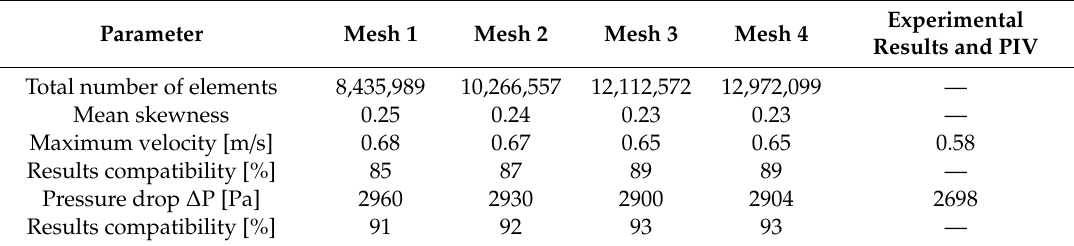
Figure 9. Velocity distributions for analyzed geometric meshes in line 2. Table 2. Characteristics of computational fluid dynamics (CFD)